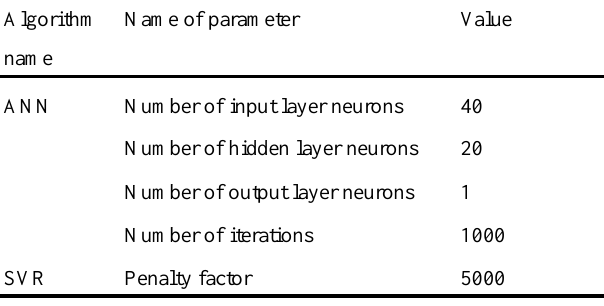
Table 3. The model optimizes the relevant parameters Algorithm